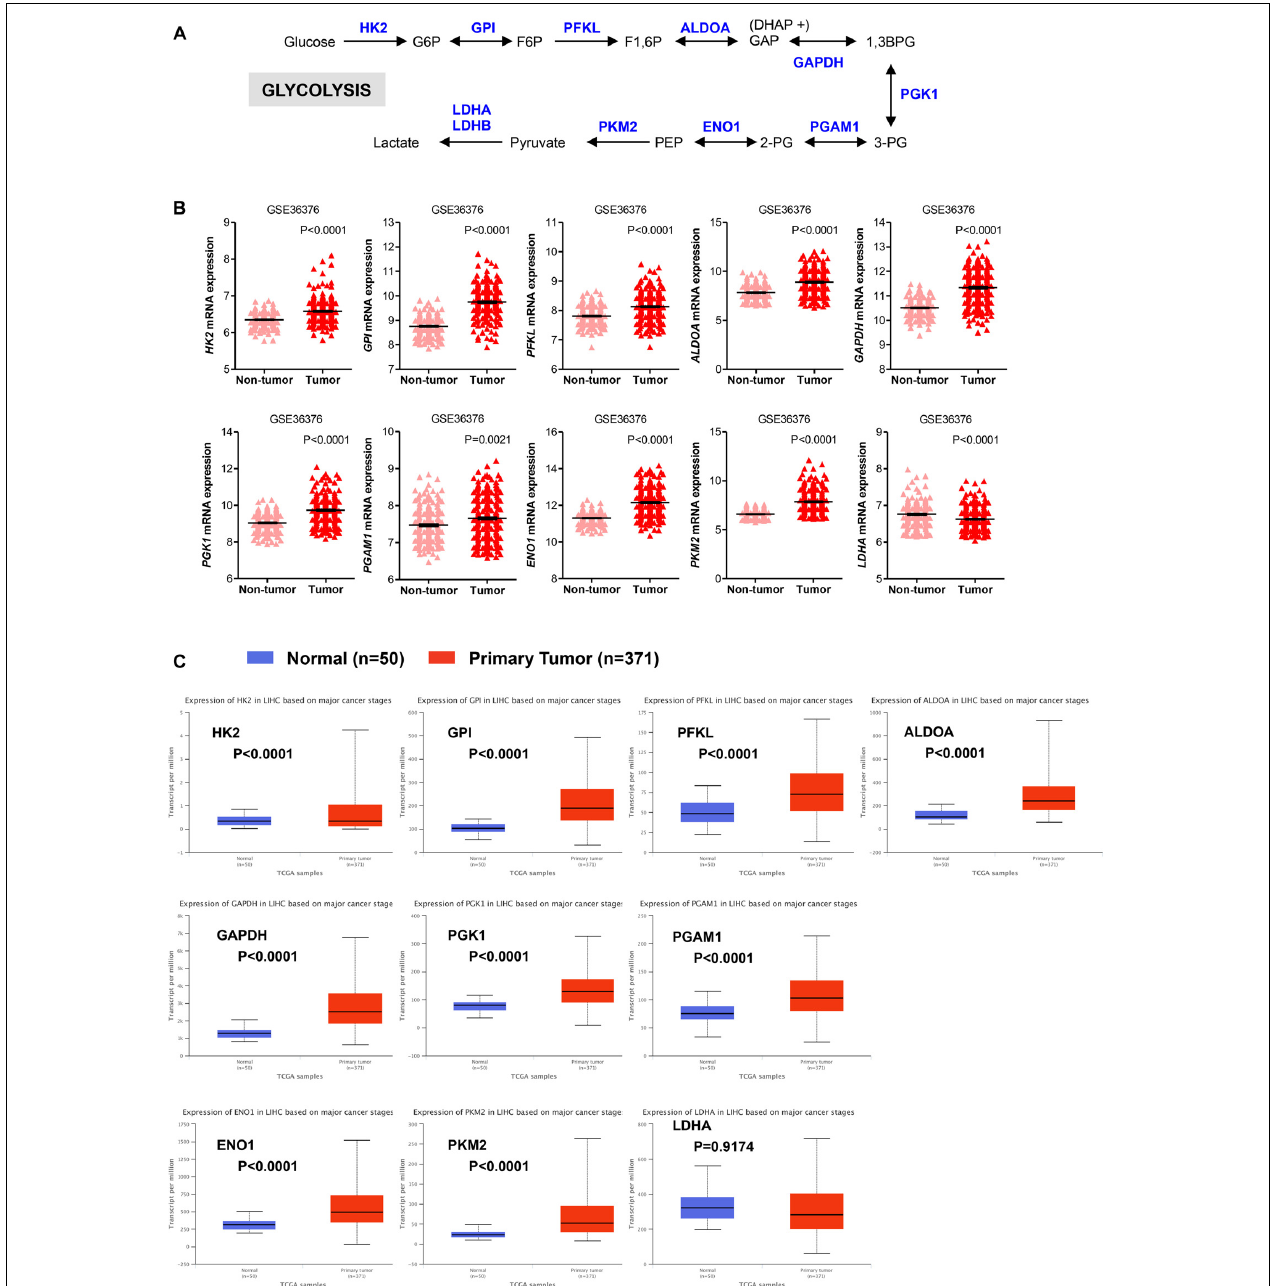
FIGURE 1 | Glycolytic genes are overexpressed in HCC. (A) A simplified representation depicting the glycolytic pathway in liver tumors. Abbreviations of the enzymes are as follows: hexokinase 2 (HK2), glucose-6-phosphate isomerase (GPI), phosphofructokinase liver isoform (PFKL), aldolase A (ALDOA), glyceraldehyde 3 phosphate dehydrogenase (GAPDH), phosphoglycerate kinase 1 (PGK1), phosphoglycerate mutase 1 (PGAM), enolase 1 (ENO1), and pyruvate kinase M2 (PKM2), lactate dehydrogenase (LDH). Abbreviations of the metabolites are as follow: glucose-6-phosphate (G6P), fructose-6-phosphate (F6P), fructose 1,6-biphosphate (F1,6BP), glyceraldehyde 3-phosphate (GAP), and dihydroxyacetone phosphate (DHAP), 1,3-biphosphoglycerate (1,3BPG), glycerol-3-phosphate (3-PG), glycerol-2-phosphate (2-PG), phosphoenolpyruvate (PEP). (B) Scatterplots showing the transcript levels of different glycolytic enzymes in the clinical data set GSE36376 consisting of HCC ( n = 240) and adjacent non-tumor ( n = 193) liver tissue (Lim et al., 2013). The horizontal lines indicate mean ± SEM P -values were calculated by non-parametric Mann–Whitney tests. (C) Boxplots showing differential gene expression of glycolytic enzymes among normal liver tissues ( n = 50) vs. primary tumor tissues ( n = 371) (TGA-LIHC samples) analyzed using the UALCAN bioinformatic tool of genomic database (Ally et al., 2017; Chandrashekar et al., 2017). Values are expressed as transcript per million. For each box plot, the whiskers represent the 2.5–97.5th percentile range of values, the lower and up boundaries denote the 25th and the 75th percentile of each data set, respectively, and the horizontal line represents the median value for each group. P -values were calculated by t -test.